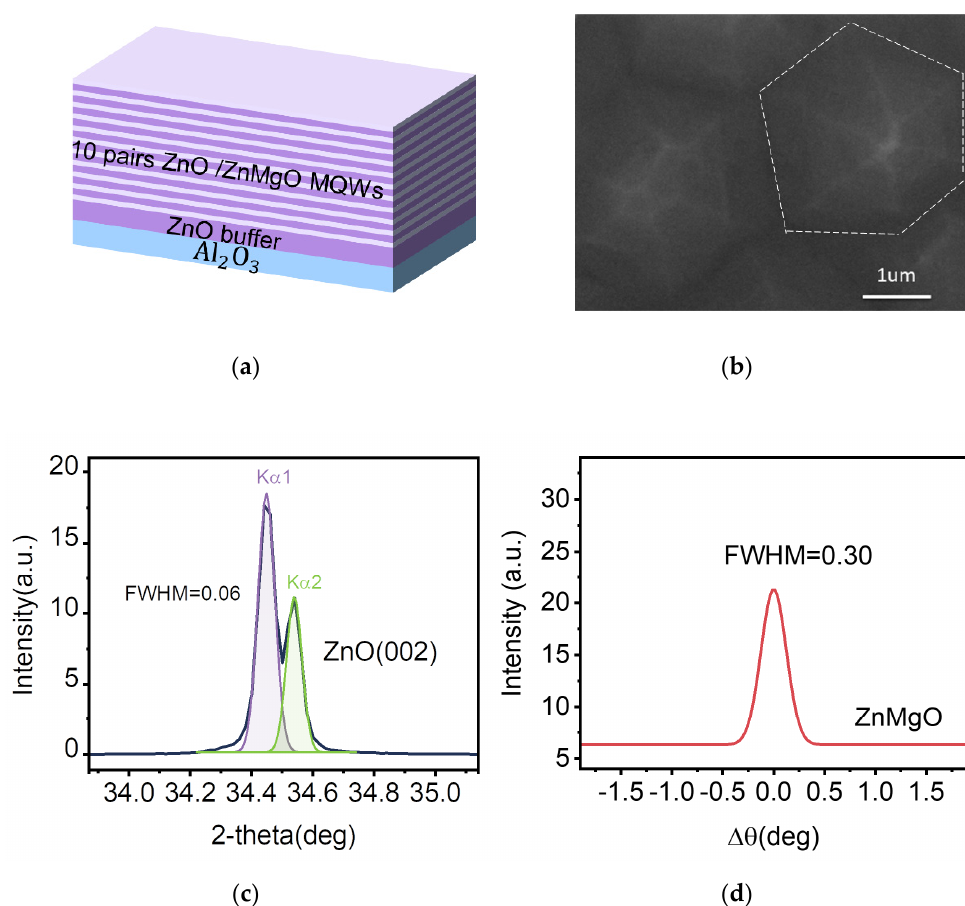
Figure 1. Structure characterizations of the ZnO/ZnMgO MQWs. ( a ) Schematic of the ZnO/ZnMgO MQWs. ( b ) The SEM image of the surface morphology of ZnO sample. ( c ) The XRD pattern of the ZnO sample. ( d ) The XRC of the ZnMgO sample.